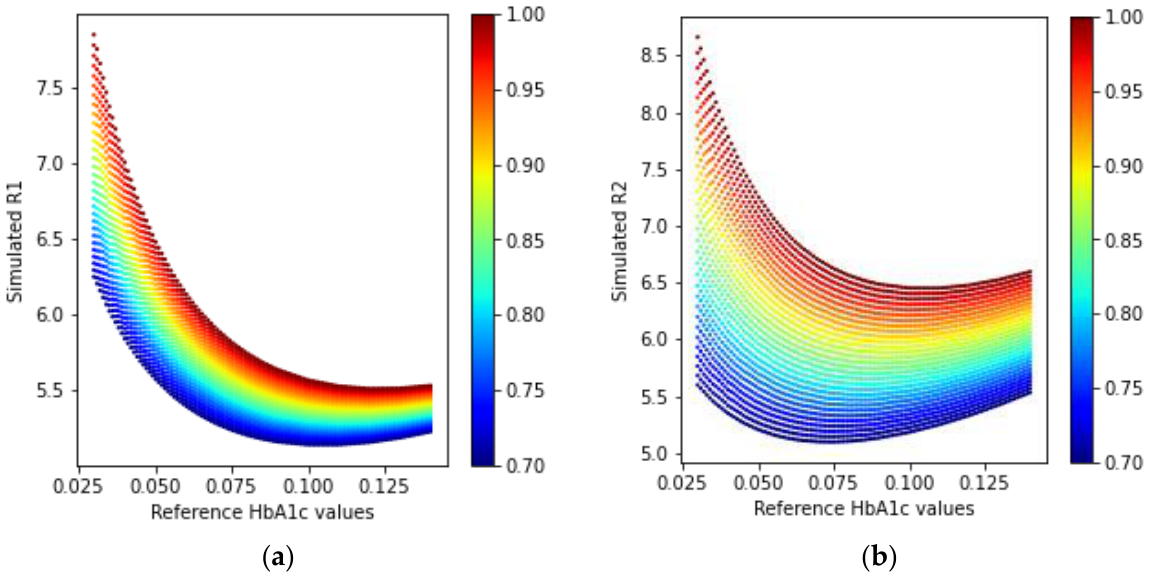
Figure 13. Simulated ratio values ( a ) R1 and ( b ) R2 from the received intensities in the reflection- type arrangement.